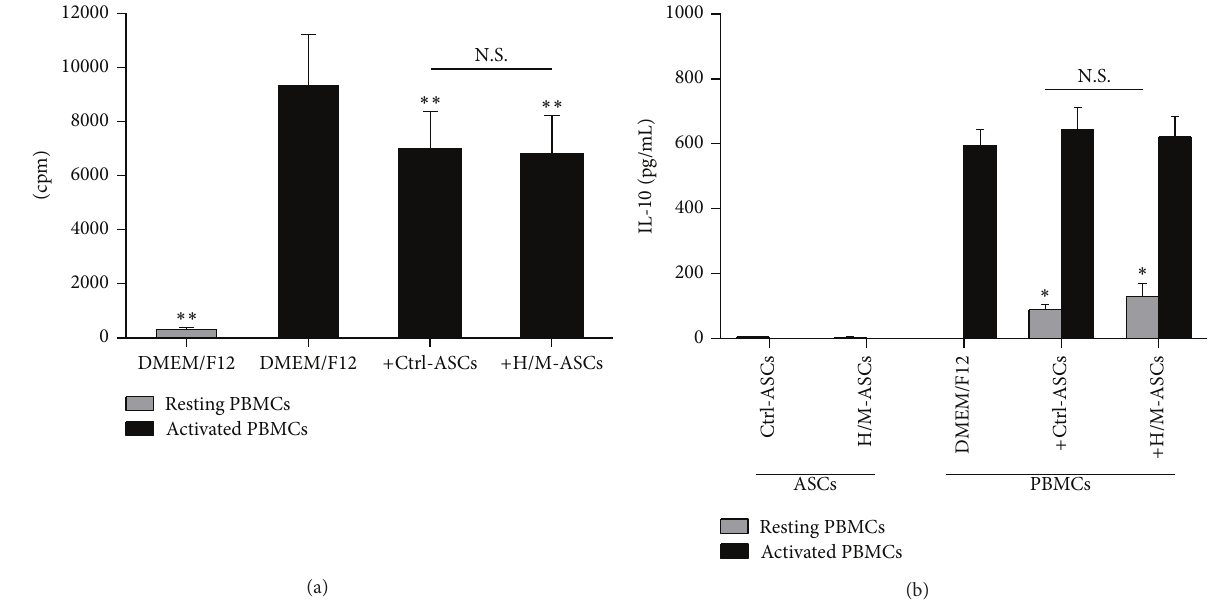
Figure 3: Effects of unstimulated and HMW/MMW adiponectin-stimulated RA-ASCs on proliferation of PBMCs from healthy donors and IL-10 secretion by these cells. PBMCs either were prestimulated with 2.5 𝜇 g/mL of phytohaemagglutinin (activated PBMCs) or were left untreated (resting PBMCs) and then cultured in the presence of unstimulated ASCs (+Ctrl-ASCs) or ASCs stimulated with 10 𝜇 g/mL of HMW/MMW adiponectin (+H/M-ASCs). Resting and activated PBMCs cultured separately in DMEM/F12 medium served as controls (DMEM/F12). Proliferation of cells was determined by 3 H-thymidine incorporation assay. Radioactivity of samples is expressed in counts per minute (cpm). Concentration of IL-10 was measured in culture supernatants by specific ELISA test. (a) Proliferation of PBMCs cocultured in the presence of ASCs ( 𝑛 = 9 ). (b) IL-10 secretion in ASCs-PBMCs cocultures ( 𝑛 = 6 ). Asterisks ( ∗ ) indicate statistically significant differences versus activated (a) or resting (b) PBMCs cultured separately; ∗ 𝑝 < 0.05 ; ∗∗ 𝑝 < 0.01 ; N.S.: